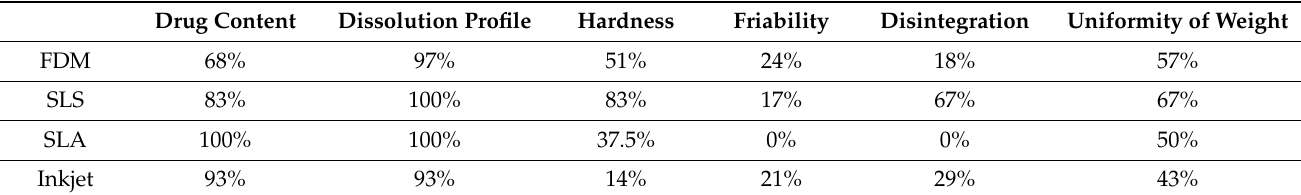
Table 1. Schematic summaries of the six characterisation tests (drug content; dissolution profile; hardness; friability; disintegration; and uniformity of weight) performed with the four 3DP techniques (FDM; SLS, SLA; inkjet 3DP) and quantification in how many articles were